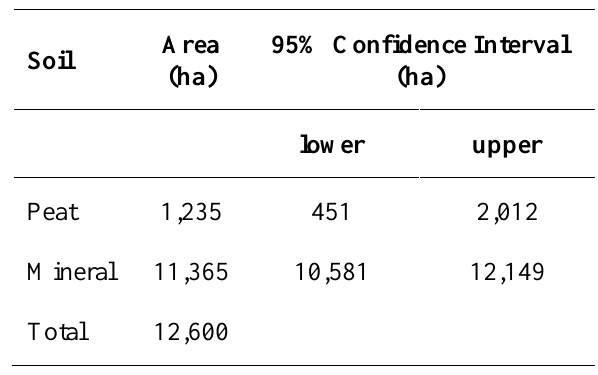
Table 3. Estimated area (in hectares) of organic soil under cultivation (2012),